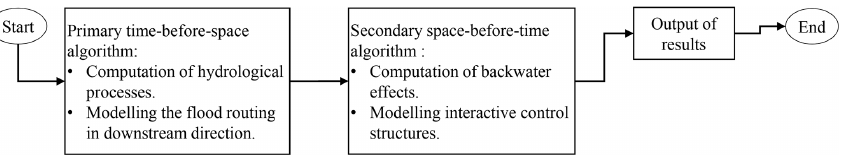
Figure 9. Structure of the implemented primary and secondary algorithm in the source code of Kalypso-NA (4.0). The enhancement of the primary algorithm is published in Hellmers and Fröhle (2017). The new (secondary) algorithm is explained in Sect. 4.3.